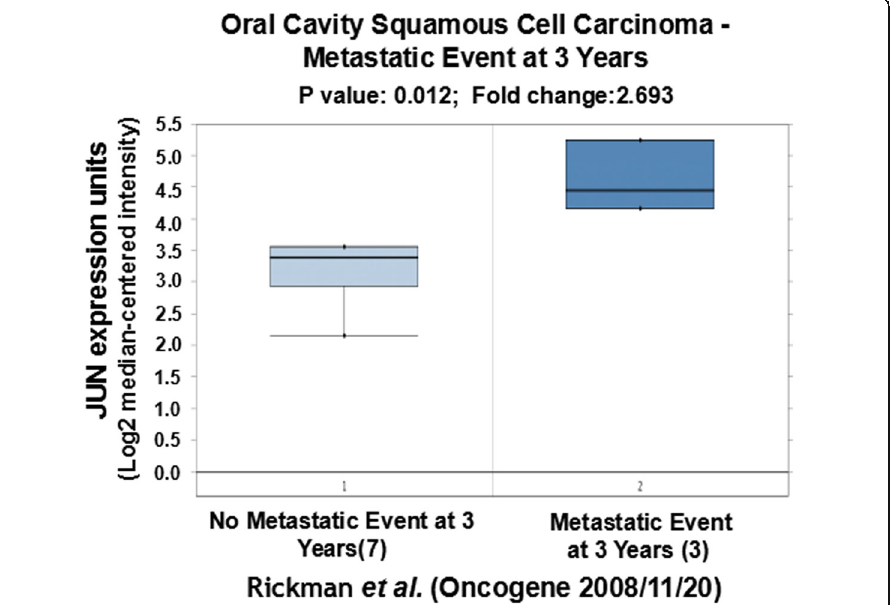
Fig. 4 Comparison of JUN expression in oral cavity squamous cell carcinoma without metastatic events